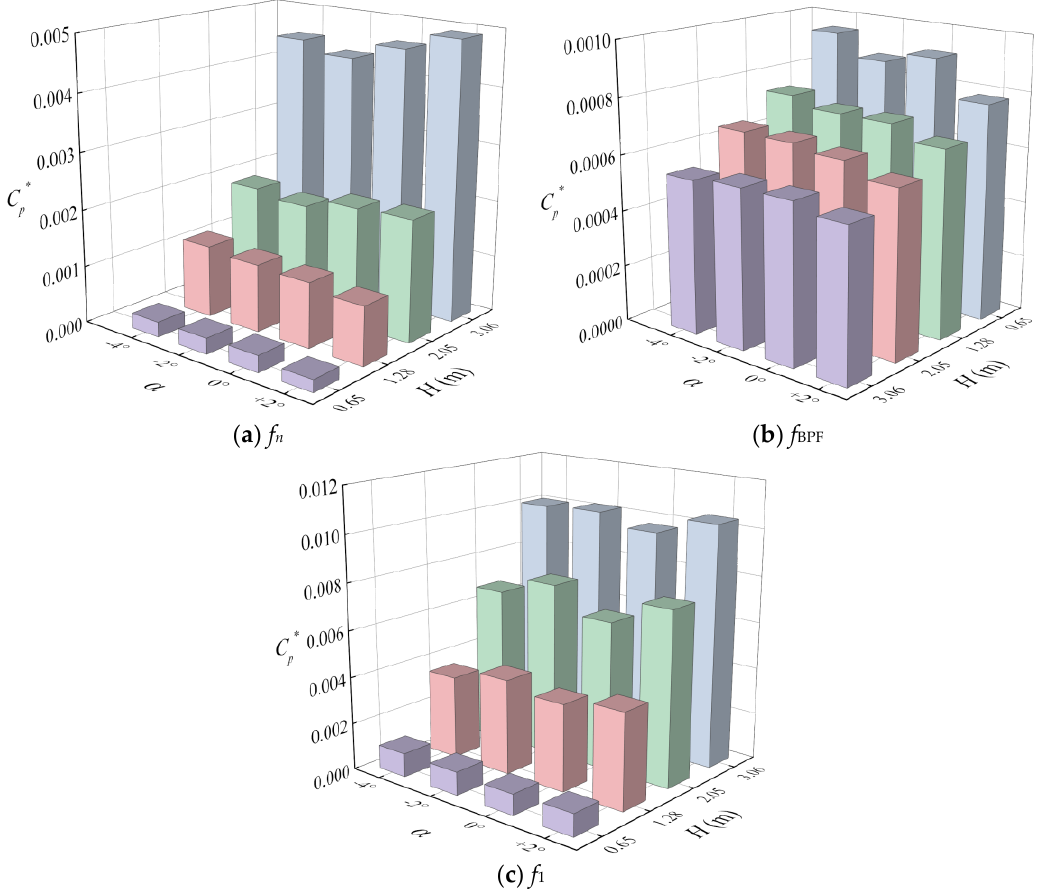
Figure 8. The * p C value with different blade angles and different runaway heads. Figure 8. The C ∗ p value with different blade angles and different runaway